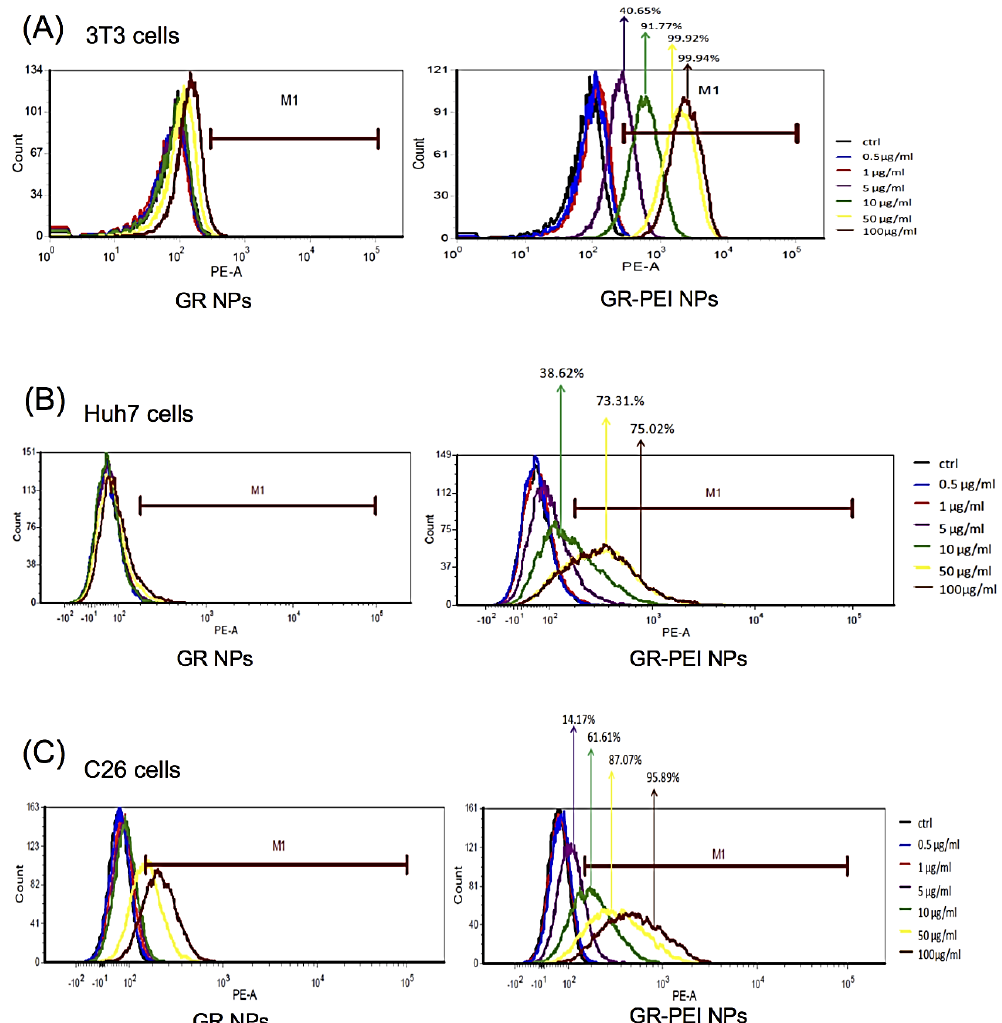
Figure 4. Cellular uptake of NPs in different cells. Cellular uptake analysis of 3T3 cells ( A ), Huh7 cells ( B ) and C26 cells ( C ) by flow cytometry. The cells were treated with different concentrations of GR NPs or GR-PEI NPs for 24 h. The cellular uptake efficiency was assayed by quantifying the percentage of rhodamine B isothiocyanate (RITC) positive cells.